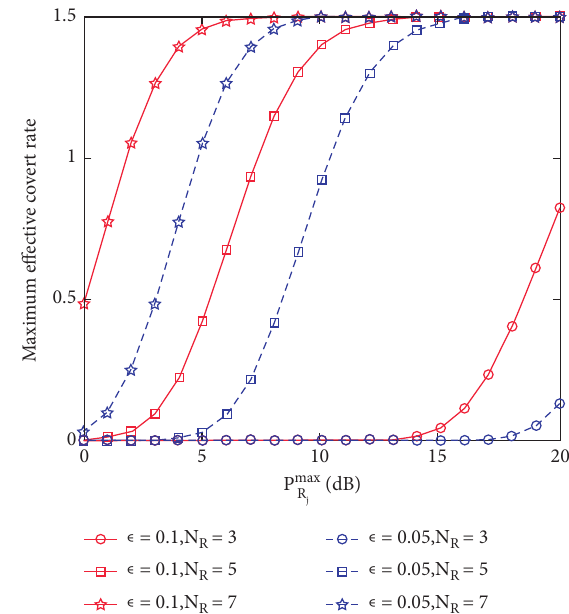
Figure 14: Maximum effective covert rate versus P max ferent value of N R and ε , where R � 1 . 5, | h R R k with dif-